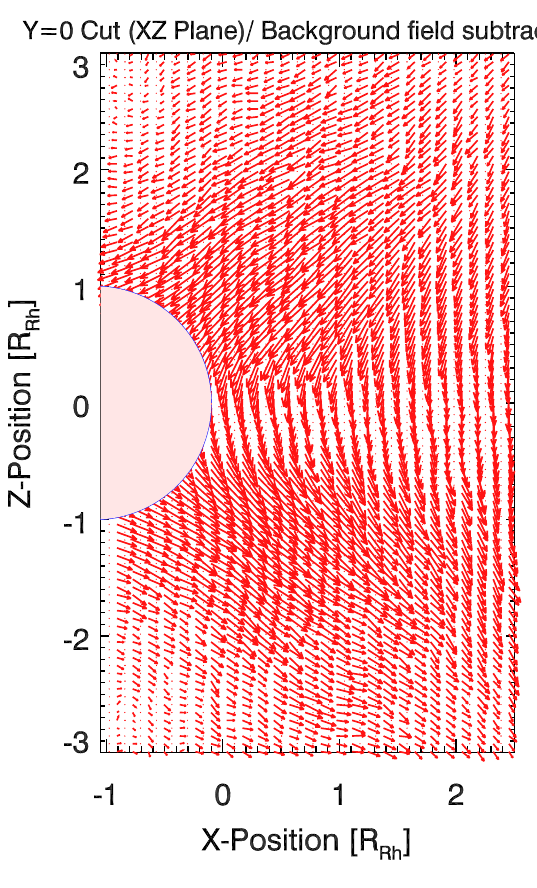
Fig. 6. Magnetic field perturbations in a the xz-plane. The back- ground field has been subtracted to enhance visibility of weak field disturbances. The peak amplitude of the residual B x is about 2nT. Also here, positive and negative B x residuals cancel out on the equator, leaving only a disturbed B z.